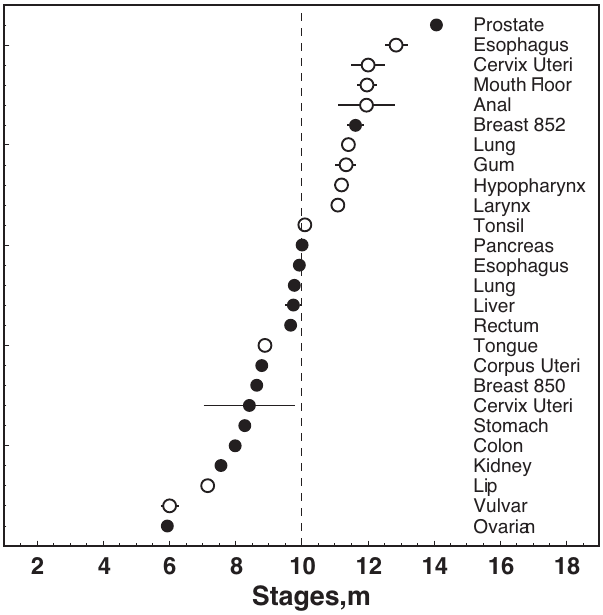
Figure 2. The estimated numbers of m- stages with respective standard errors (SE) for ACs (black dots) and SCCs (circles). Note: breast 850 – breast duct carcinoma, breast 852 – breast lobular carcinoma.